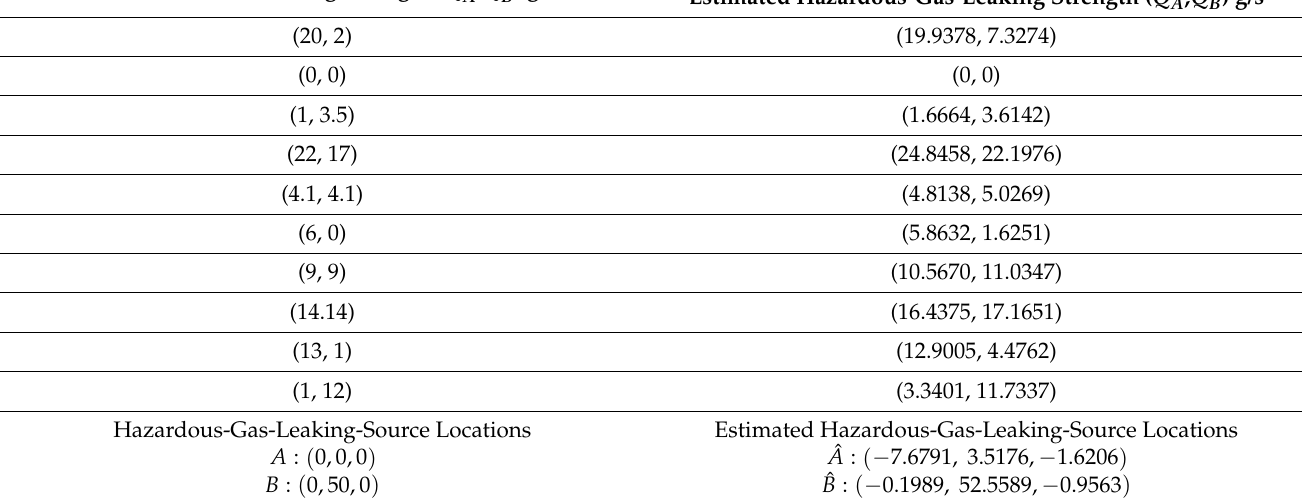
Table 7. Online STE results in a case when the data from 4 sensors are